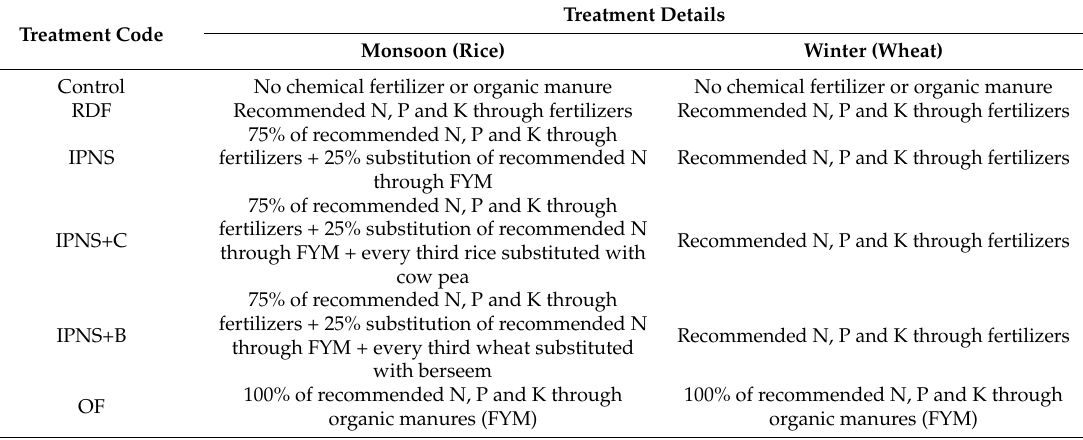
Table 2. Treatment details of the long-term experiment chosen for different nutrient management